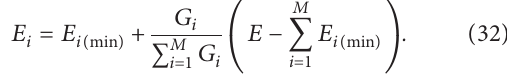
Algorithm 2. The process of solving the resource allo- cation based on the Lagrange multiplier